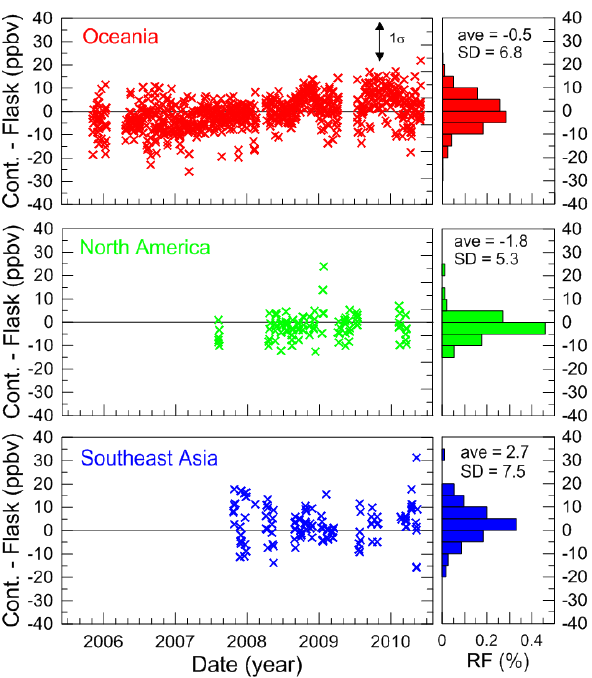
Figure 8. Temporal variations (left) and relative frequency (RF) distributions (right) of the differences between continuous (cont.) measurements and flask analysis measurements for the Oceania, North America, and Southeast Asia route. The typical analytical precision of continuous measurements by GFC (1 σ ) is illustrated by a doubled-headed arrow (left). The averages and standard deviations (SD) are also indicated (right). Each bin is 5 ppbv.